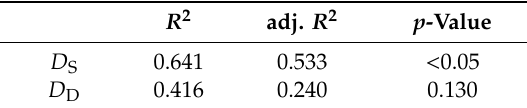
Table 5. Coe ffi cients of determination R 2 , adjusted R 2 values and p -values for the multivariate linear